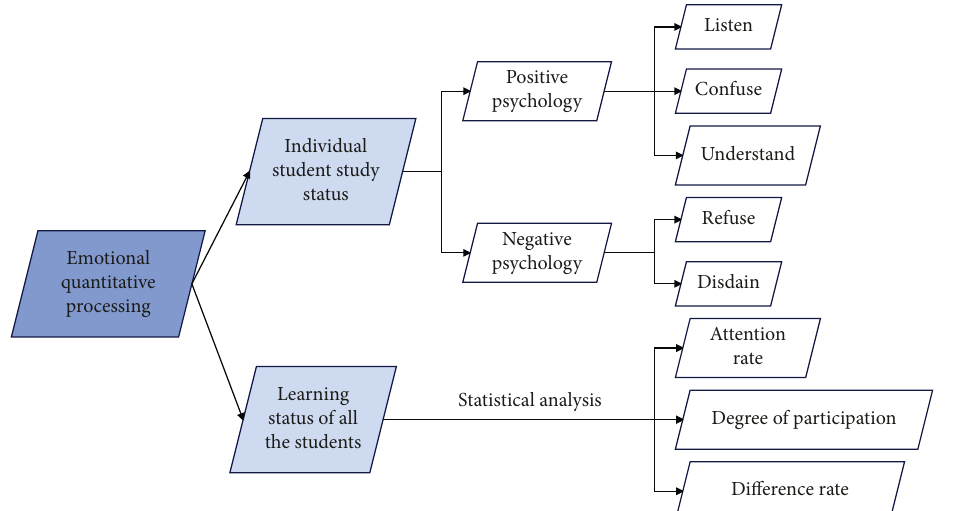
Figure 7: Design ideas of the intelligent emotional English teaching evaluation system.